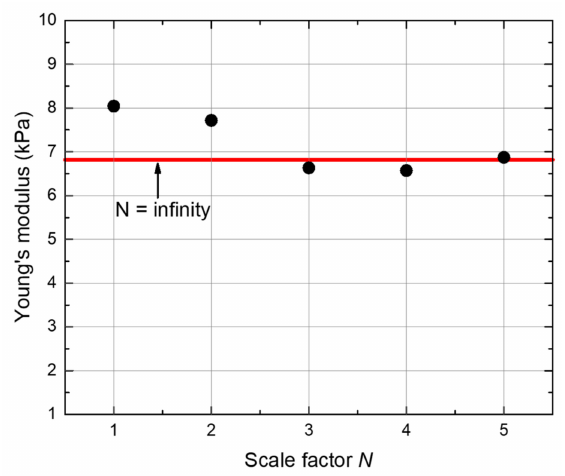
Figure 5. Young’s moduli of the pentamode structure (a = 37.3 µ m, D = 2 µ m and d = 0.5 µ m) with N × N × 2 N extended unit cells ( N = 1, 2, 3, 4, 5). The horizontal line refers to the value of Young’s modulus for the infinite